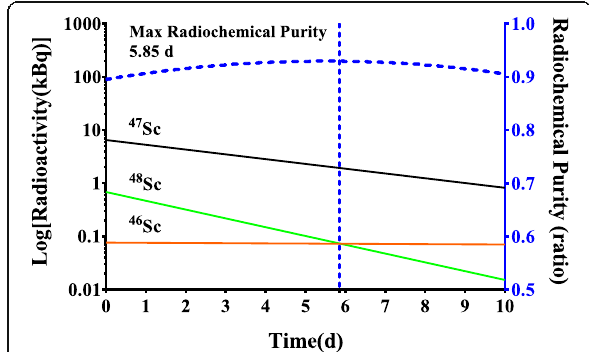
Fig. 2 (Left axis) The radioactive decay of 46,47,48 Sc and (right axis) 47 Sc radioisotopic purity produced during the third irradiation modeled over 10 days